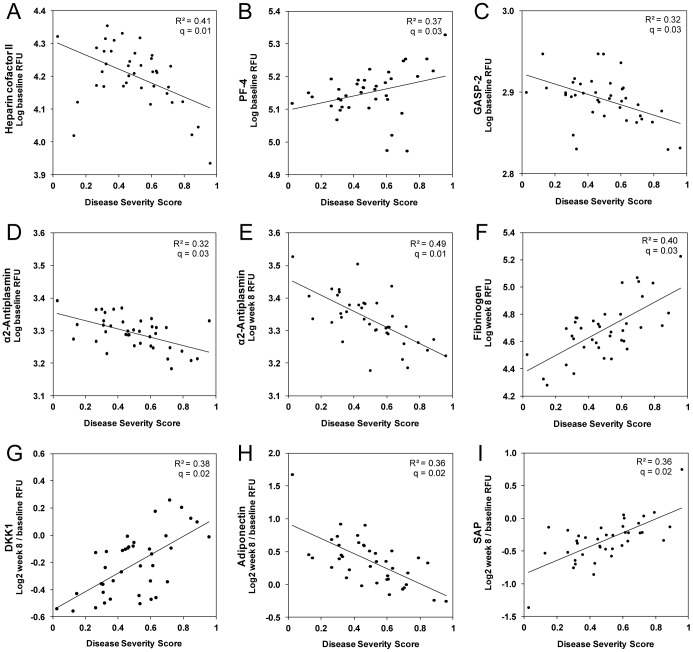
Correlation of serum protein markers with TB disease severity.Top markers that showed the largest differential expression in mild disease (n = 13) compared to severe disease (n = 13), based on medians at baseline. Log10 RFU was used as the response in a linear model and a 5% false discovery rate, A–D: Markers of disease severity identified via linear regression analysis of the protein concentration correlated with disease severity score at baseline. E-F: Levels of α2-antiplasmin and fibrinogen (respectively) relative to disease severity score at 8 weeks. G-I: Markers of disease severity based on a regression analysis of the expression shift from baseline to week 8.